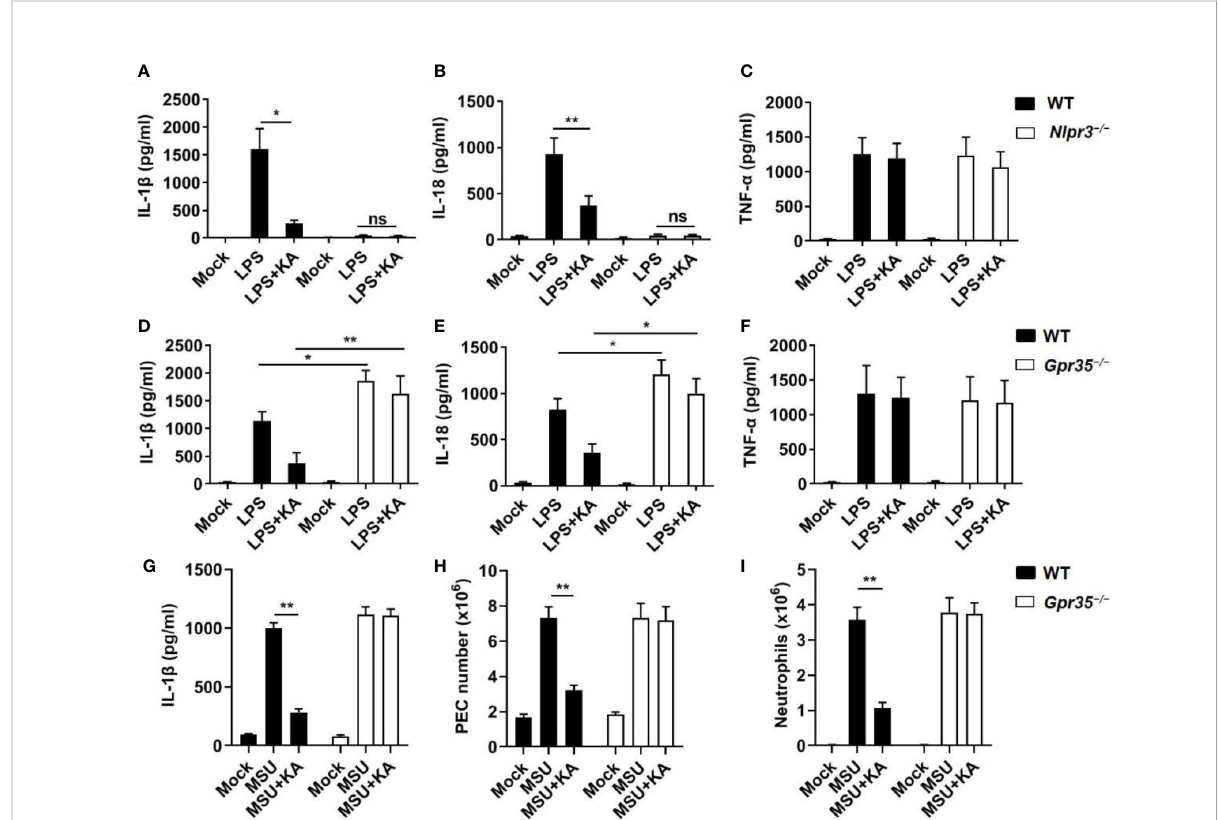
FIGURE 5 KA mitigates NLRP3 in fl ammasome-mediated in fl ammatory diseases. (A-C) ELISA of IL-1 b (A) , IL-18 (B) , and TNF- a (C) in serum from WT and Nlrp3 − / − mice intraperitoneally injected with LPS (20 mg·kg − 1 body weight) with or without KA (50 mg·kg − 1 body weight). (D-F) ELISA of IL-1 b (D) , IL-18 (E) , and TNF- a (F) in serum from WT and Gpr35 − / − mice intraperitoneally injected with LPS (20 mg·kg − 1 body weight) with or without KA (50 mg·kg − 1 body weight). (G-I) ELISA of IL-1 b (G) , the peritoneal exudate cell (PEC) number (H) , and neutrophil number (I) in the peritoneal cavity from WT and Gpr35 − / − mice intraperitoneally injected with MSU crystals (1 mg·mouse − 1 ) in the presence or absence of KA (50 mg·kg − 1 ). Data are representative of three independent experiments and show as the mean ± SEM. Statistical signi fi cance was analysed by the nonparametric Mann − Whitney test: *p < 0.05, **p < 0.01; ns, no signi fi